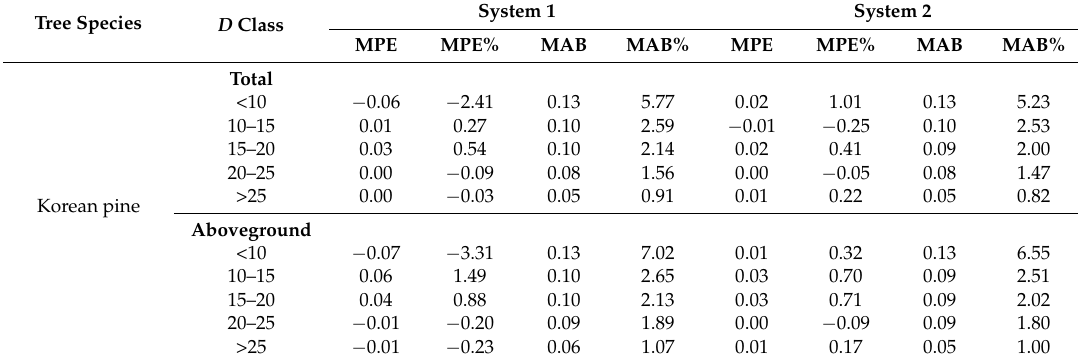
Table A1. Validation in tree components of log-transformed biomass equations by diameter classes. Tree